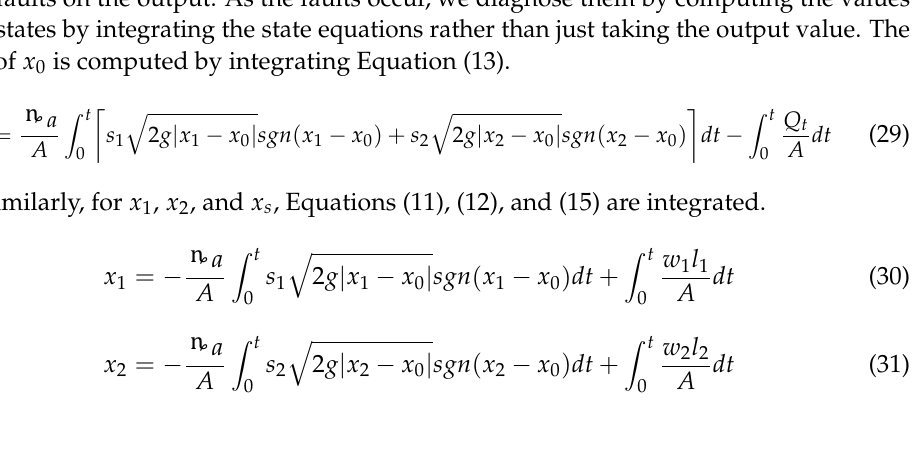
Figure 1. Three-pond hydraulic system.